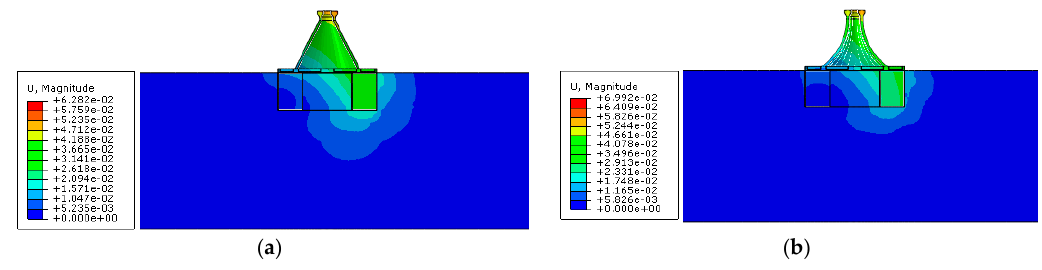
Figure 9. Displacement under ultimate load: ( a ) Line type; ( b ) Arc type.